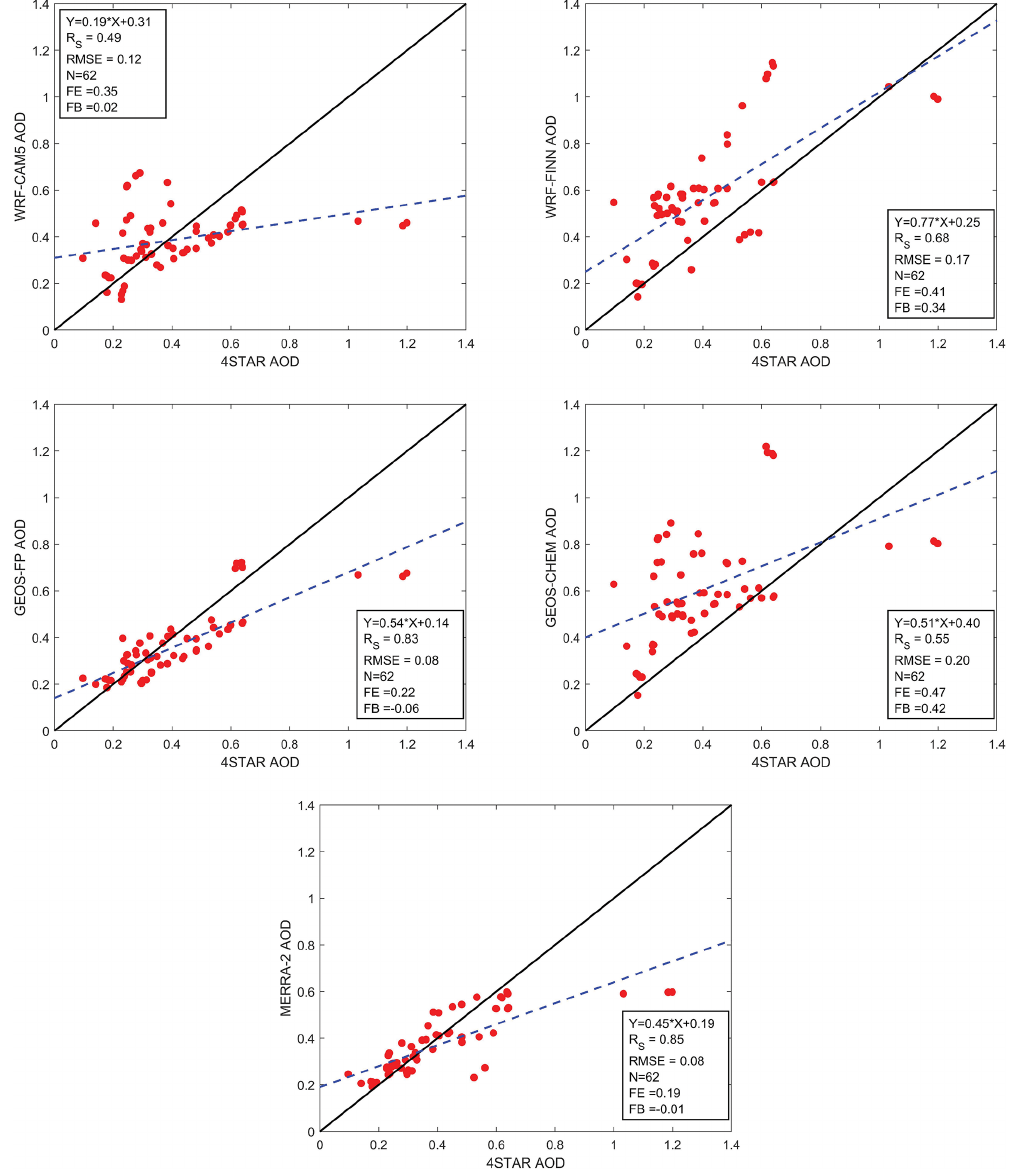
Figure 13. Scatterplots comparing modeled AOD (at 550nm) and 4STAR AOD during August 2017 of the ORACLES field